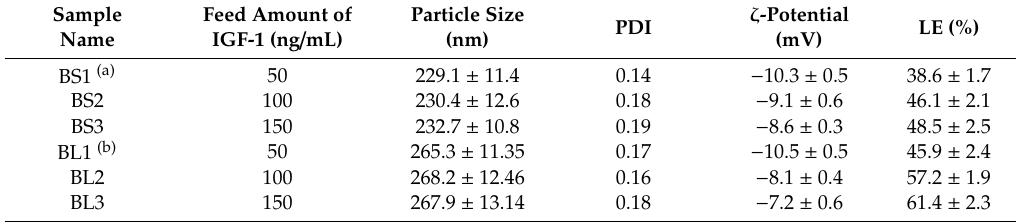
Table 2. Parameters for insulin-like growth factor-1 (IGF-1)-loaded BG